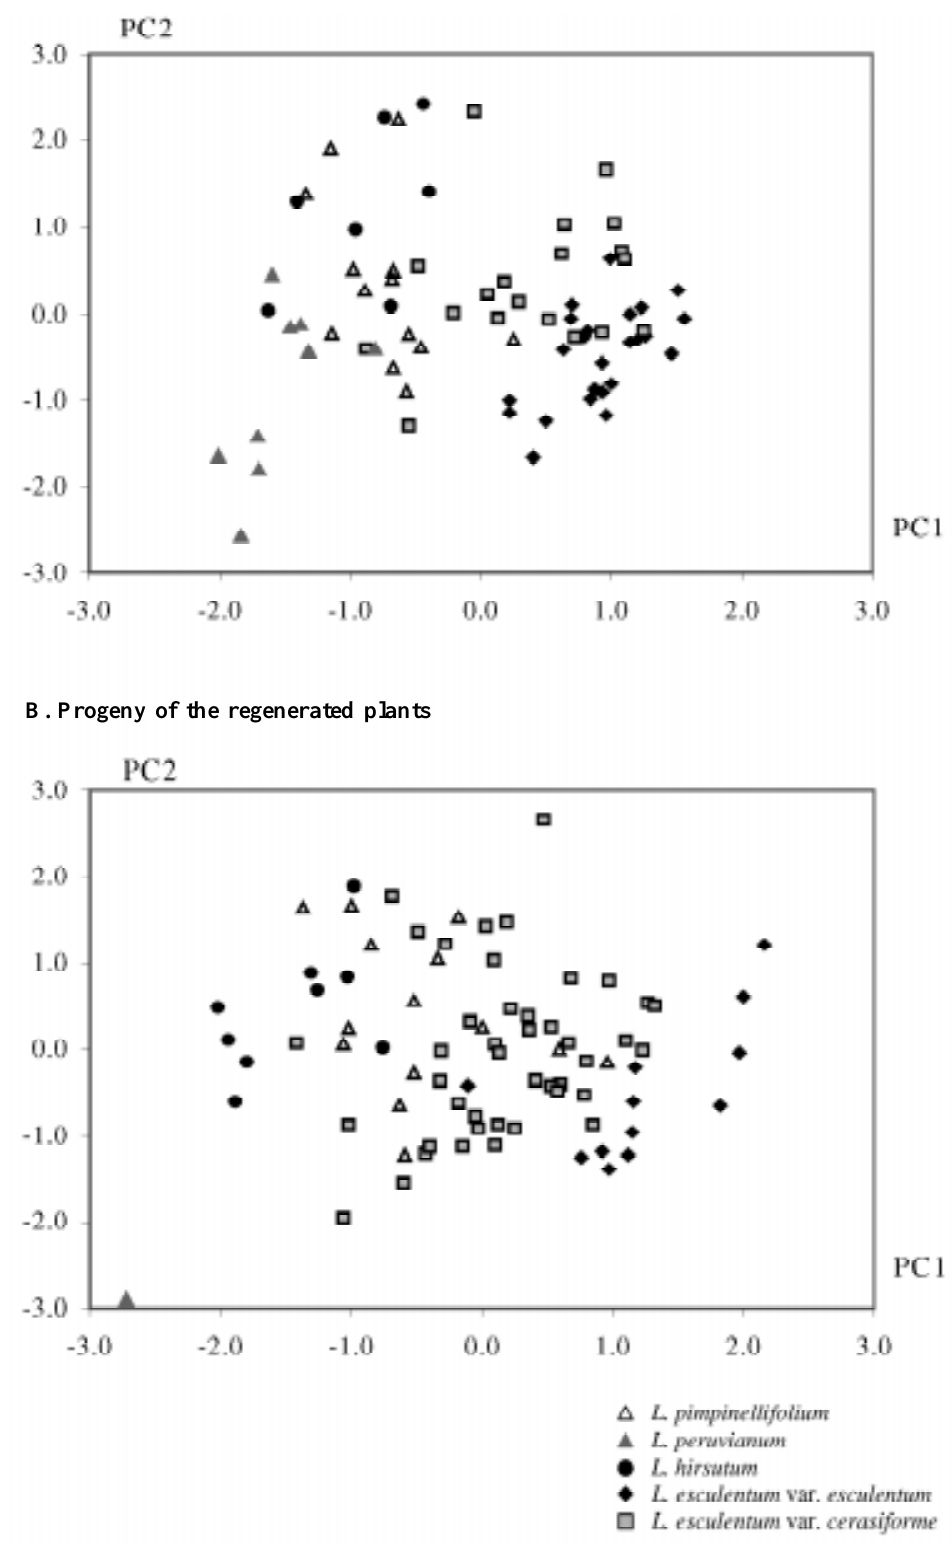
Figure 1 - Individual plants by species on the basis of principal component 1 (PC1) and principal component 2